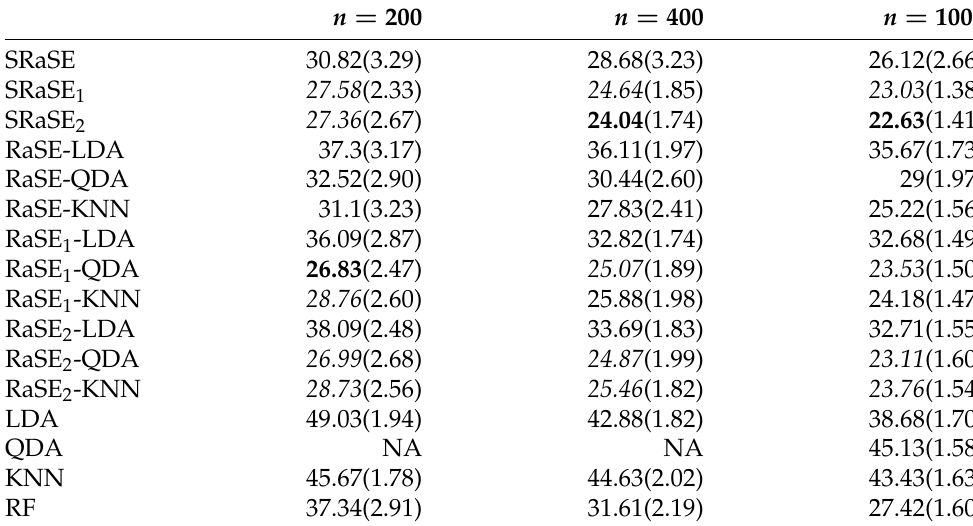
Table 2. Summary of test classification error rates for each classifier under various sample sizes over 200 repetitions in Model 2 (QDA). The results are presented as mean values with the standard deviation values in parentheses. Here, the best performing method in each column is highlighted in bold and the methods that are within one standard deviation away are highlighted in italic. n = 200 n = 400 n =